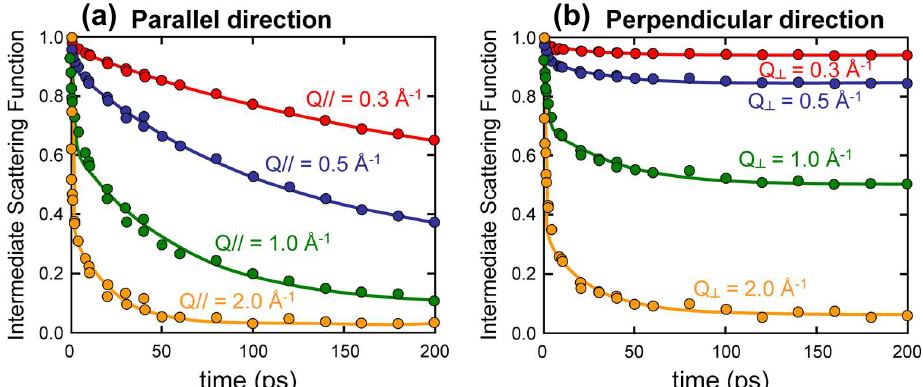
Figure 4. Time evolution of the Intermediate Scattering Function, in Equation (3), evaluated by numerical simulations of Molecular Dynamics for hydrated samples of saponite neutralized by Na + counterions, along the directions parallel ( a ) and perpendicular ( b ) to the clay layers. Reprinted with permission from Ref. [28]. Copyright (2012) American Chemical